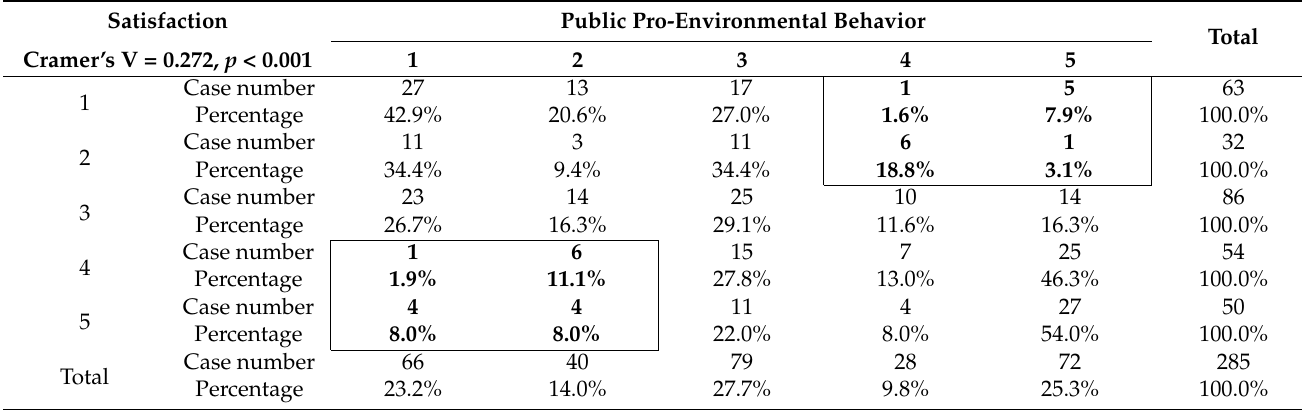
Table 13. Cross-contingency table of satisfaction and public pro-environmental behavior.